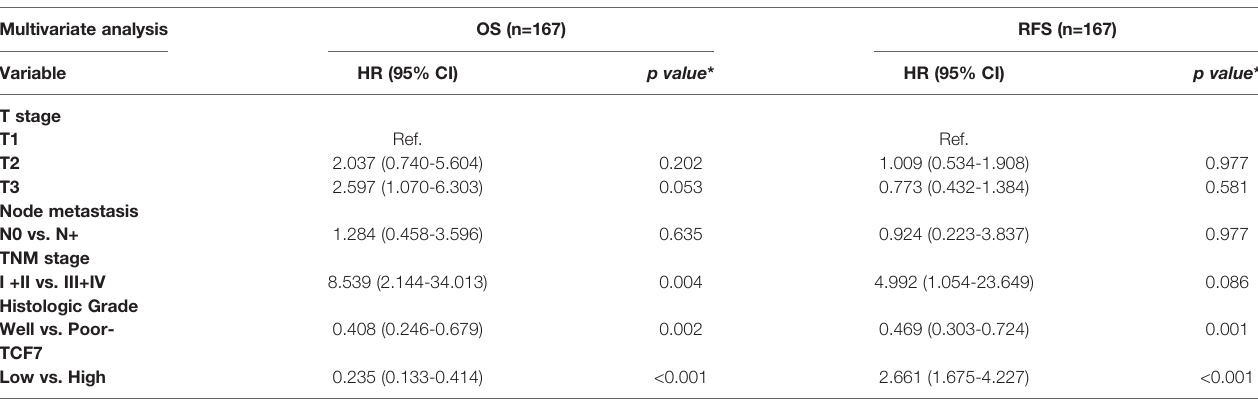
TABLE 3 | Multivariate analysis of factors associated with overall survival. Multivariate